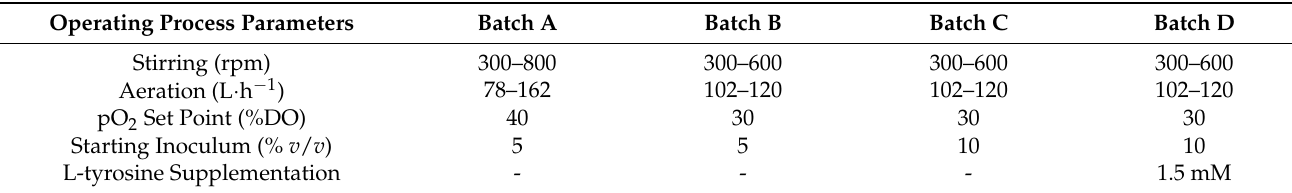
Table 1. Bioreactor experiment parameters: stirring and aeration, pO 2 set point, starting inoculum percentage and L-tyrosine supplementation.